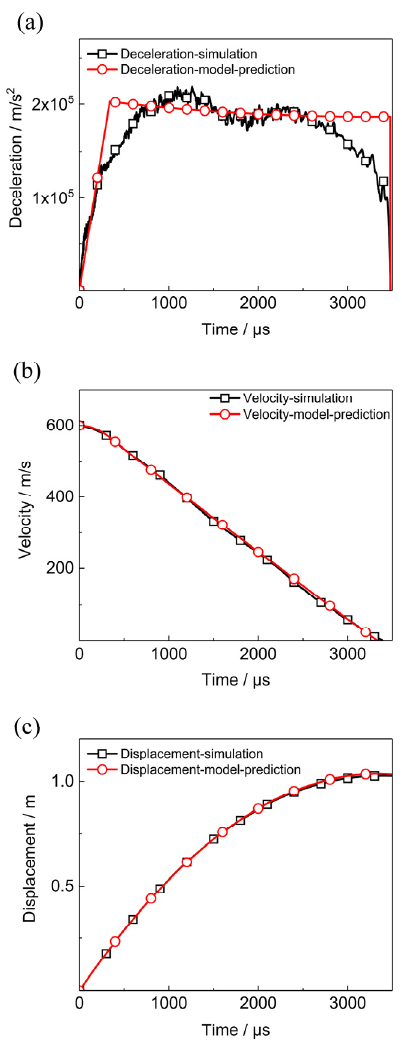
Figure 13. Comparisons of the calculated deceleration, velocity, and displacement of the EPM in the simulation and the corresponding variables predicted by using the cavity expansion theory. ( a ) Decceleration, ( b ) velocity, ( c ) displacement.